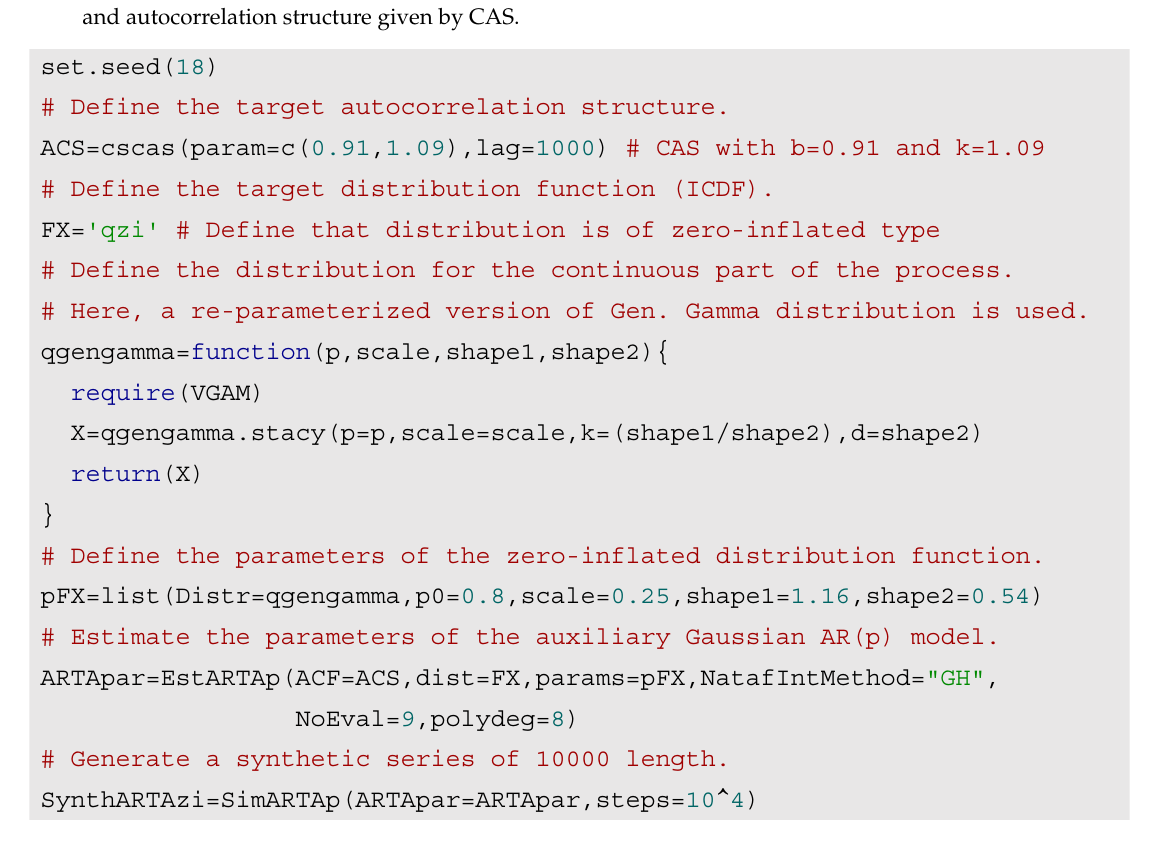
Figure 2. Simulation of univariate stationary processes with: (first row, a – c ) continuous distribution function; (second row, d – f ) with discrete distribution; and (third row, g – i ) with zero-inflated distribution. The figure displays: (first column, a , d and g ) the simulated realization of the